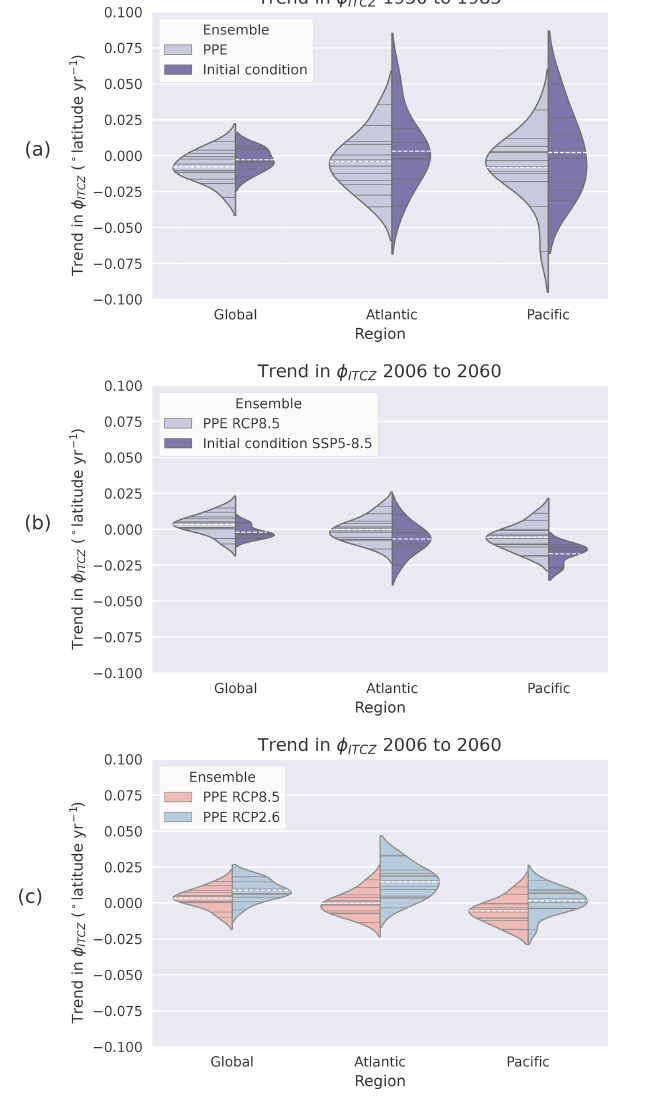
Figure 4. Trend in 5-year rolling mean (cid:56) ITCZ for (a) 1950 to 1985 and (b, c) 2006 to 2060 for global (left), Atlantic (middle) and Pa- cific (right) regional means. The violin plots in light purple (in b ) and red (in c ) are equivalent. The black lines within the violin plots show individual ensemble members (13 in the PPE, 8 in the initial condition ensemble), and the white dashed lines show the ensemble